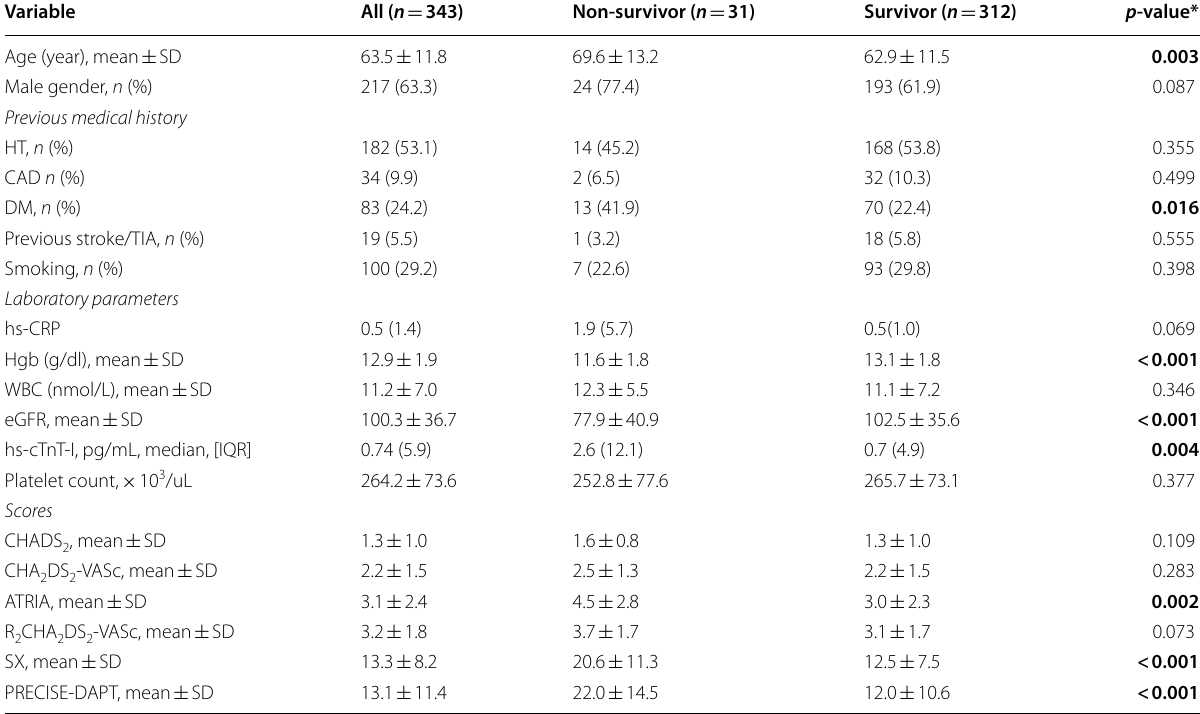
Table 1 Demographic and laboratory parameters of the study population